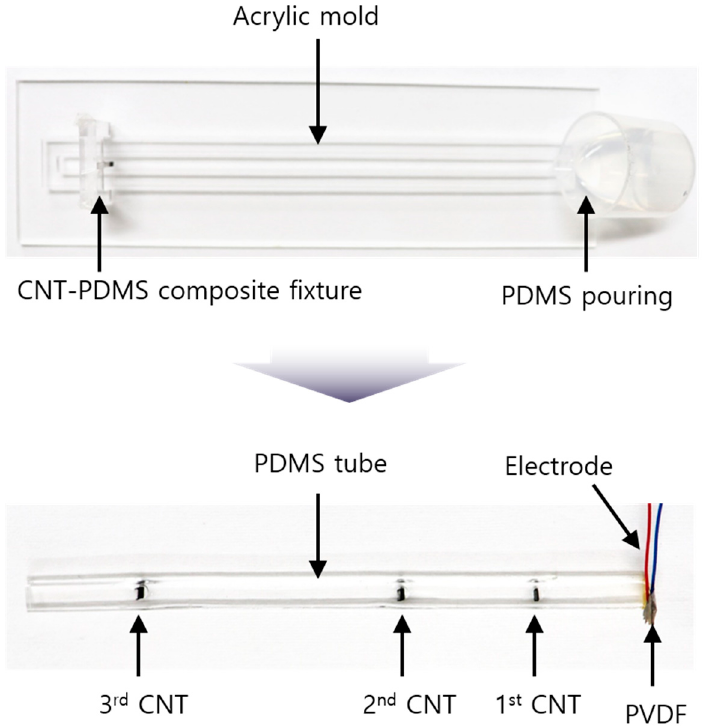
Figure 2. Photographs taken during the fabrication of the strain sensor.